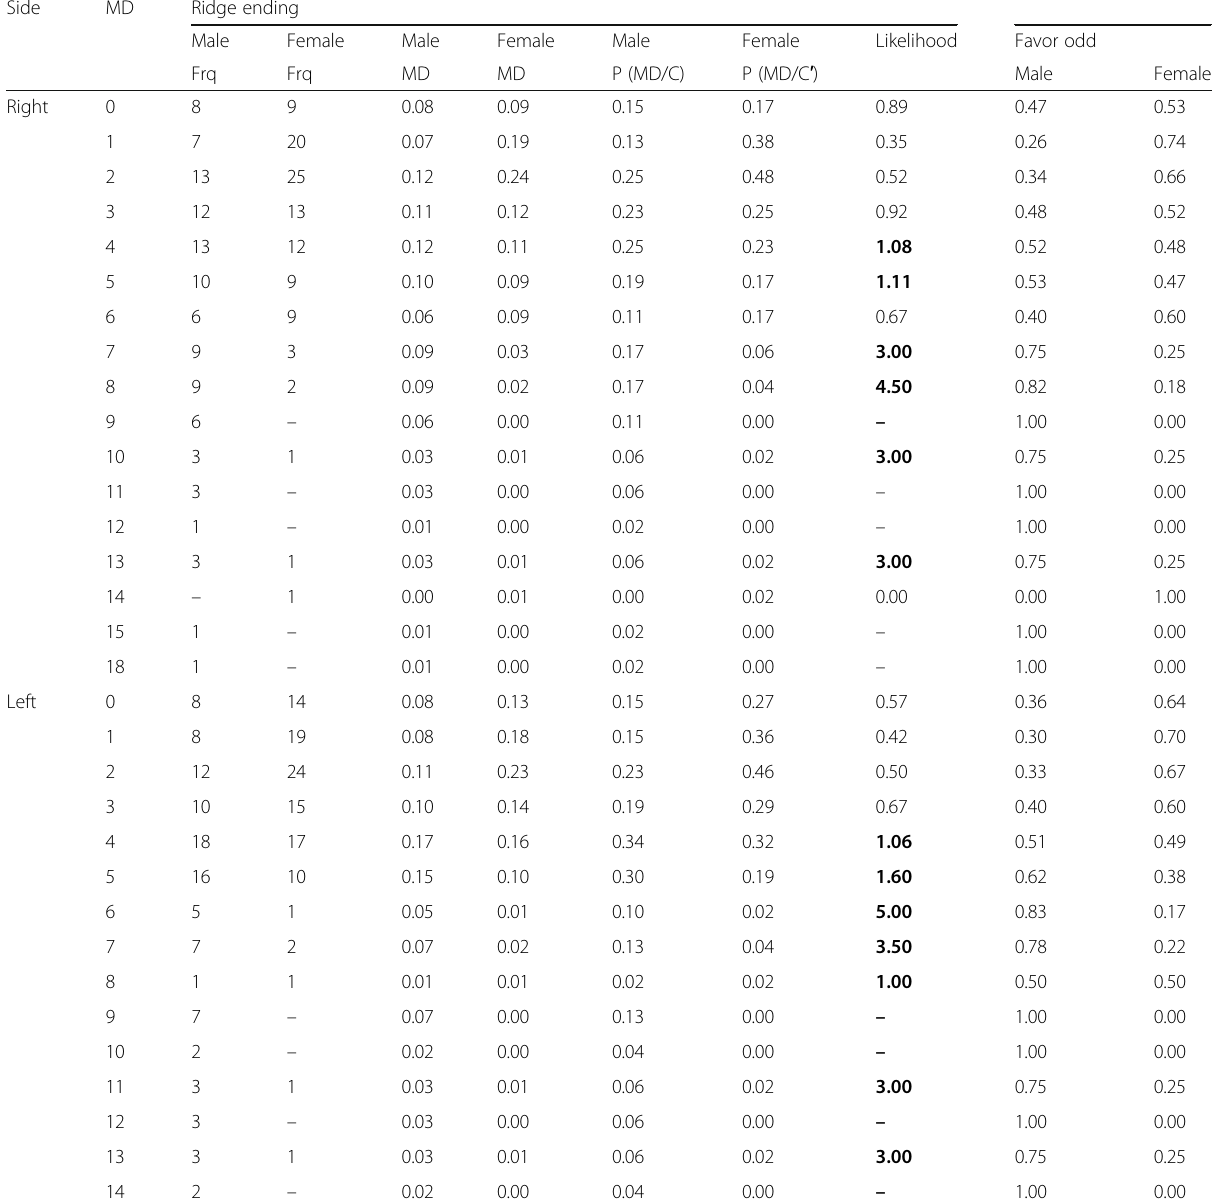
Table 2 Frequency, likelihood ratio and favor odd of different ridge ending density of right and left thumbprints Side MD Ridge